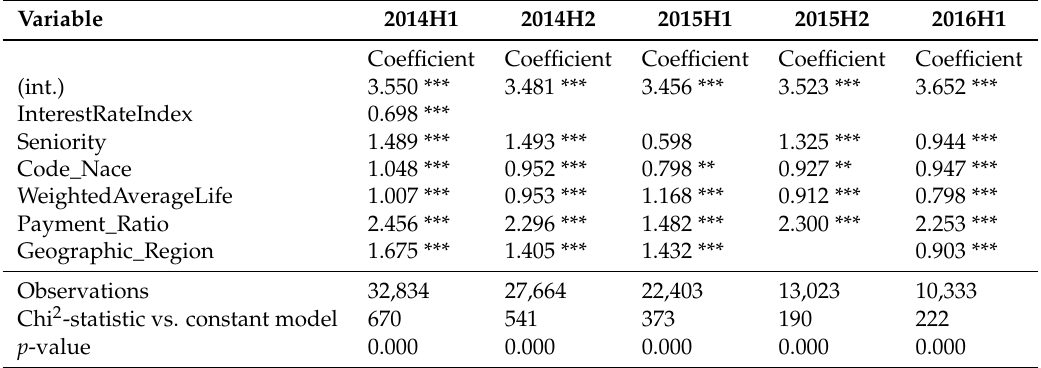
Table 5. We illustrate in the table the coefficient and the significance of the variables included in the regression. We denote by *** the significance level of 1%, with ** the level of 5%. The table reports the number of observations, Chi 2 -statistic vs. constant model and p -value.